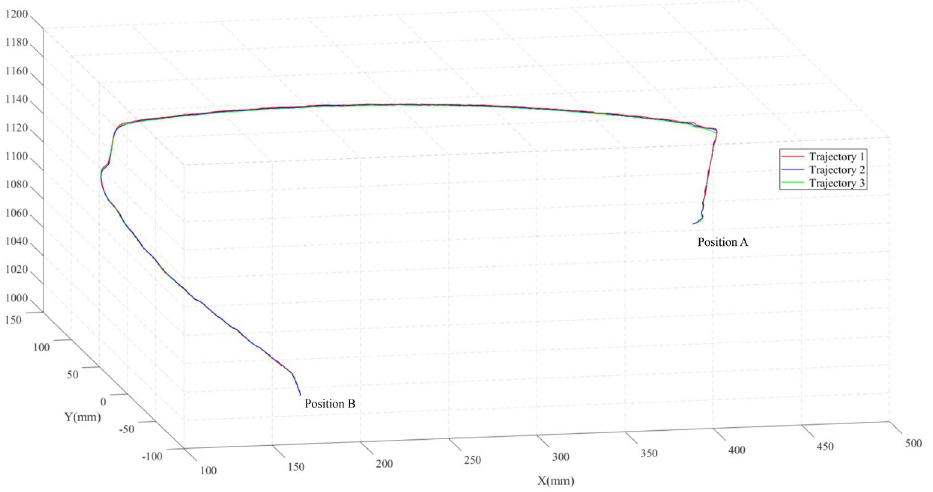
Figure 11. Trajectory analysis of manipulator when moving object from position A to position B.